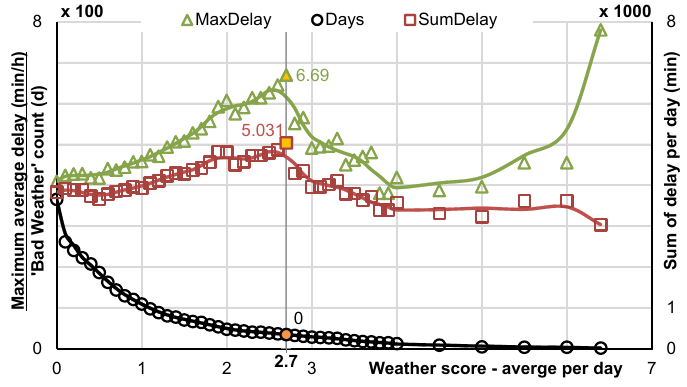
Figure 8. Identification of relevant weather impacts.